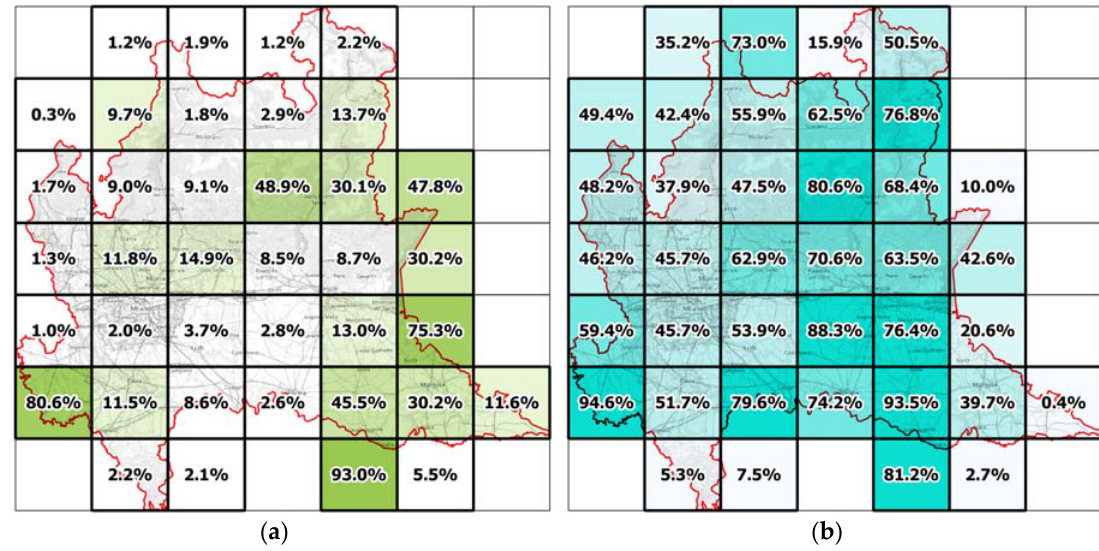
Figure 10. ( a ) Percentages of OSM buildings without a corresponding DBT building; ( b ) percentages of DBT buildings without a corresponding OSM